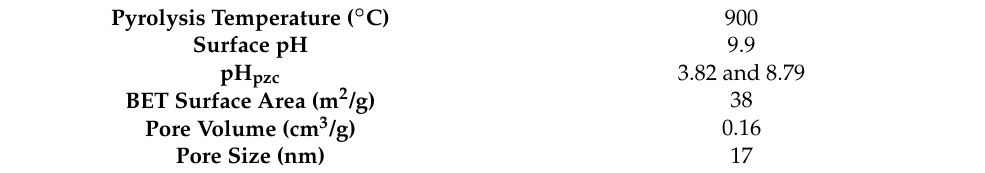
Table 2. (BC/nTiO 2 ) P characteristics.